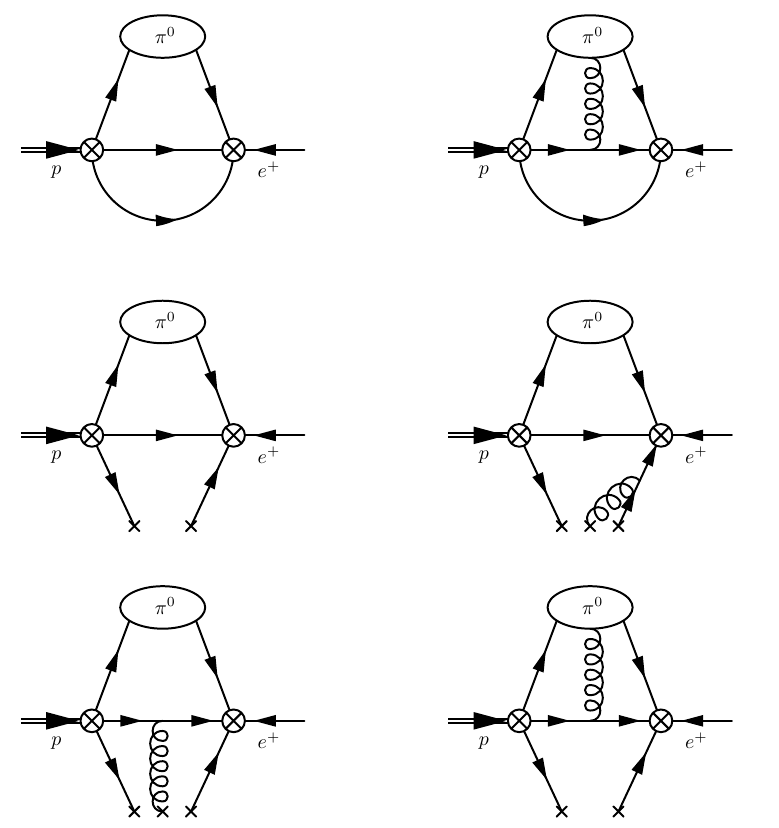
Figure 1 . Feynman diagrams contributing to the light-cone expansion of (3.1) at the twist-2 and twist-3 level including factorised higher-twist contributions. The two vertices with a circled cross denote insertions of the currents Q ΓΓ 0 ( x ) and η (0) . We attach the external proton and positron lines for illustration even though they do not enter the LCSR computation. The diagrams shown in the top row result from the light-cone expansion (3.7). The diagrams in the middle and bottom row instead originate from factorised higher-twist contributions, which involve the condensates h ¯ qq i and h ¯ qg s G · σq i of (3.8) and (3.9) (crosses on the bottom of the diagram). See text for further